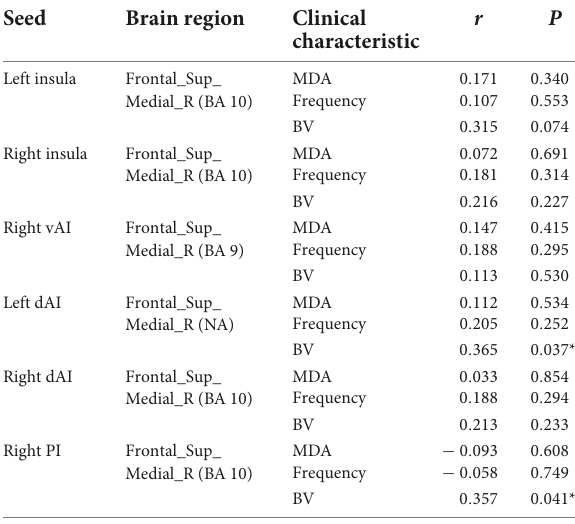
TABLE 3 Simple correlation analysis between clinical characteristics and FC z -values of the insula or its subregions with other brain regions in PNE subjects (with global signal regression).